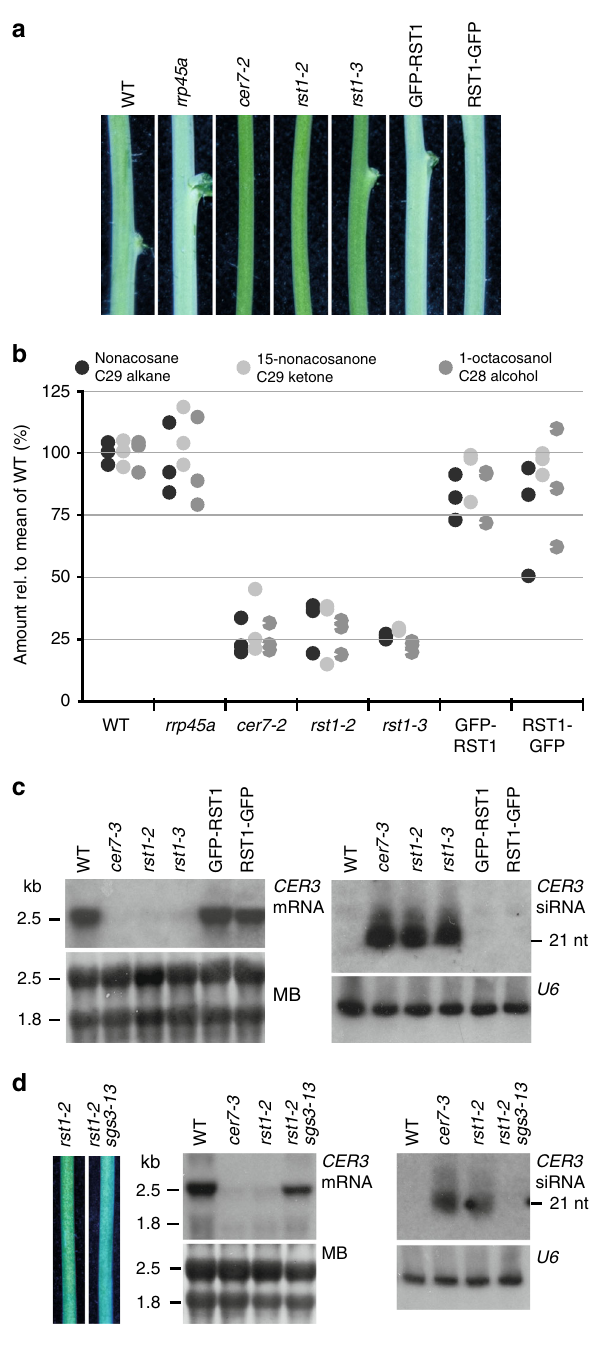
rst1-4 plants had reduced levels of the full-length MIM156 tran-